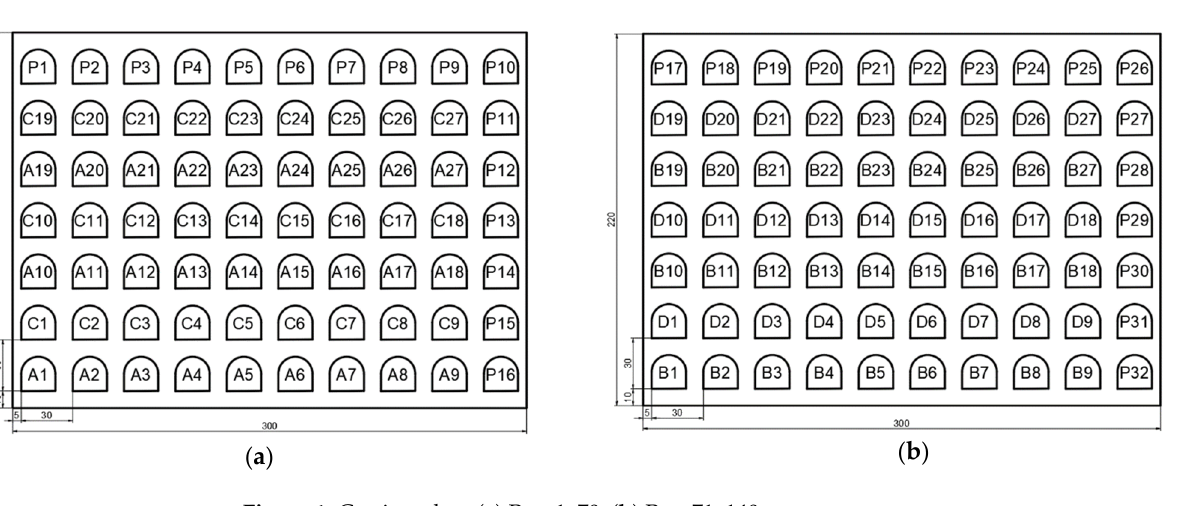
Laser power in the piercing phase (W)